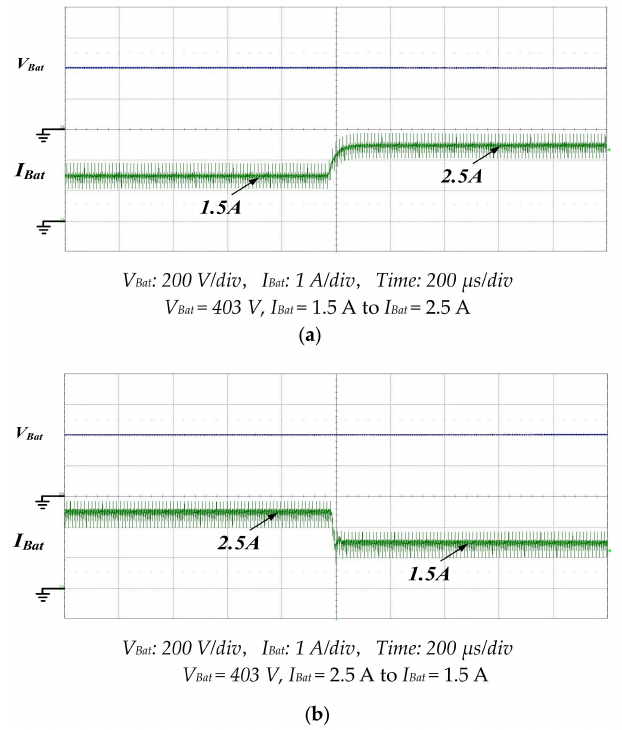
Figure 15. The voltage state under abrupt load current fluctuation: ( a ) load current changes from 1.5 A to 2.5 A; ( b ) load current changes from 2.5 A to 1.5 A.